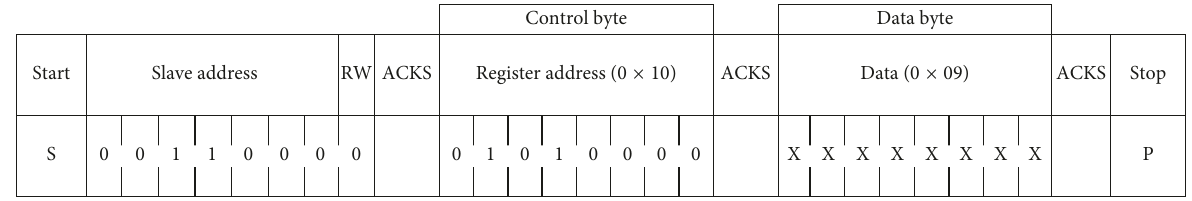
Figure 16: IIC protocol transmission flow